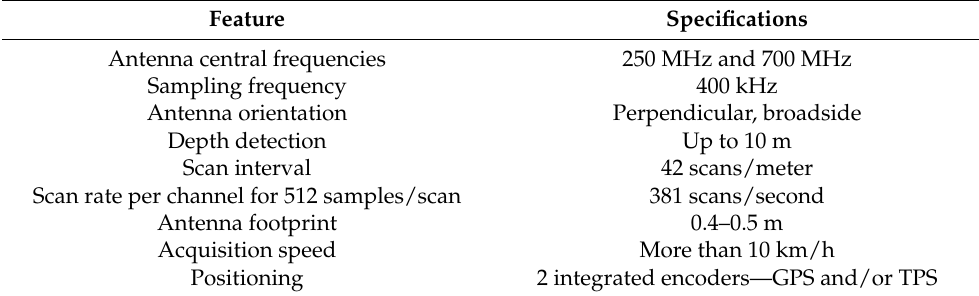
Table 1. Technical parameters of the DS2000 Leica ground-penetrating radar